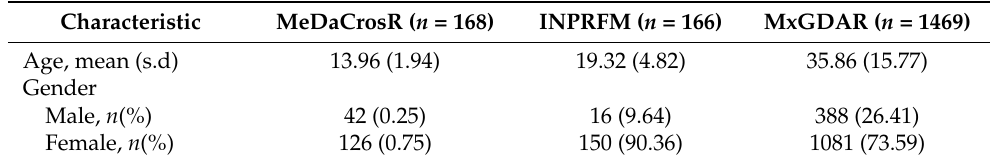
Table 1. Overview of the characteristics of the